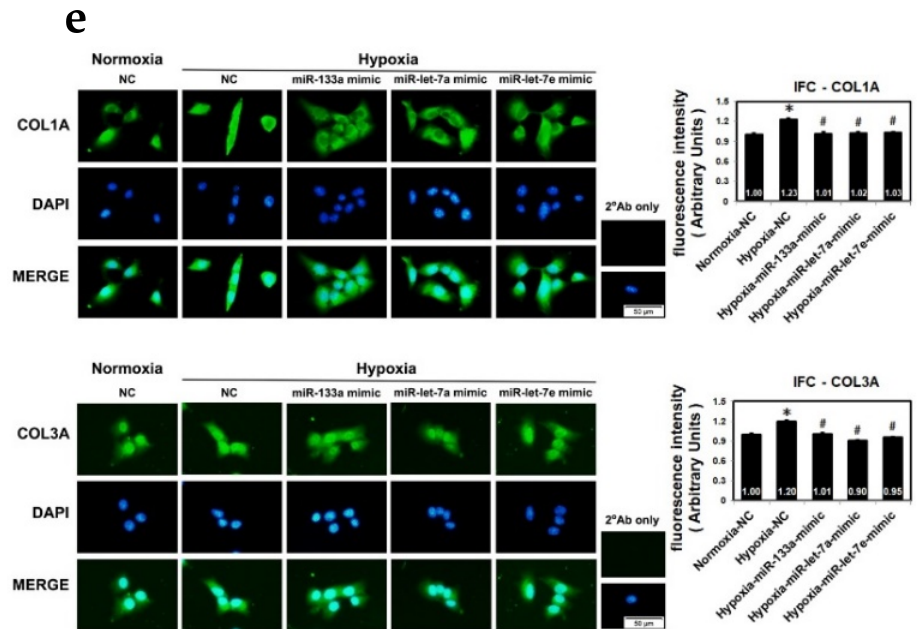
Figure 3. Regulation of collagen type 1A1 and 3A1 by miR-133a and let-7 family under hypoxic stress. ( a ) The HL-1 cells transfected with miRNA mimic were exposed to a hypoxic microenvironment and the levels of miR-133a, miR-let-7a and miR-let-7e were determined for transfection effectiveness from each group. ( b ) Western blotting analysis and quantification ( c ) of COL1A and COL3A protein expression in HL-1 cells transfected with the indicated mimic miRNA. ( d ) qRT-PCR analysis of COL1A1, COL1A2 and COL3A mRNA expressions in HL-1 cells transfected with the indicated mimic miRNA. Mean ± SD, n ≥ 3, * p < 0.05. ( e ) Effect of extracellular matrix shown by immunofluorescent